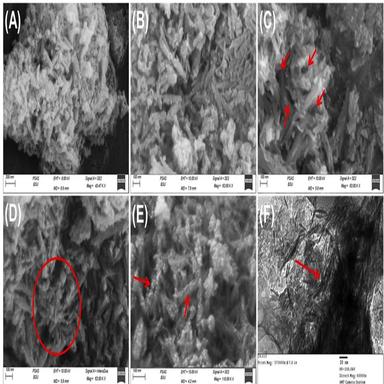
(A) Scanning electron microscopy (SEM) image of the as-synthesized Mg-doped hydroxyapatite nanofibers (Mg.HAPNFs). High-resolution SEM images of (B) Mg.HAPNFs bundles, (C) porous matrix formed by overlapping Mg.HAPNF bundles (red arrows indicate pores), (D) flower-like shaped formed by Mg.HAPNF bundles, and (E) nanodots decorating the surfaces of Mg.HAPNF bundles. (F) High-resolution transmission electron microscopy image of Mg.HAPNF bundles.